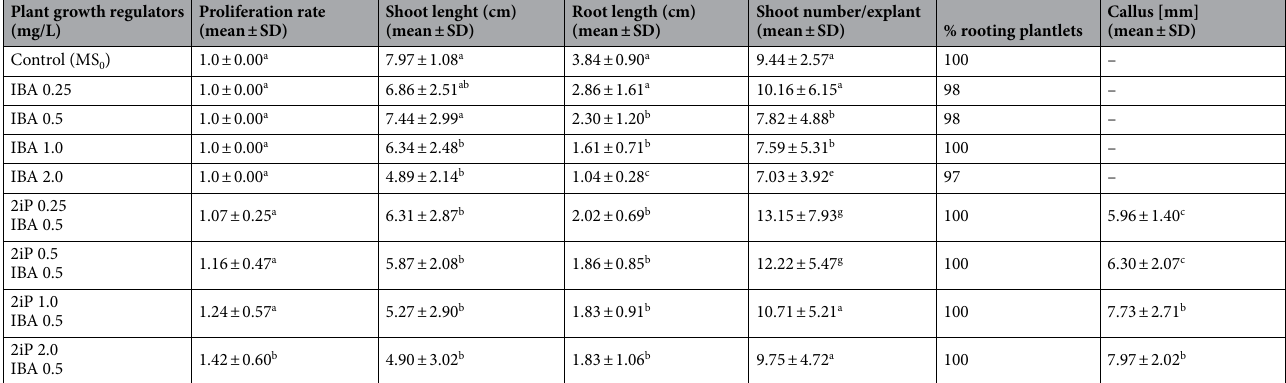
Table 6. Effect of 2iP and IBA supplementation on the development of P. amarus shoot culture. The results are the arithmetic means of ≥ 50 trials ± SD The values in each column marked with different letters (a, b, c …) indicate statistically significant differences (p < 0.05; Tukey’s RIR